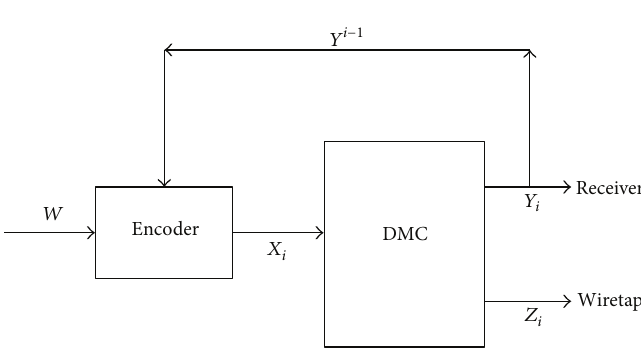
Figure 3: The general wiretap channel with noiseless